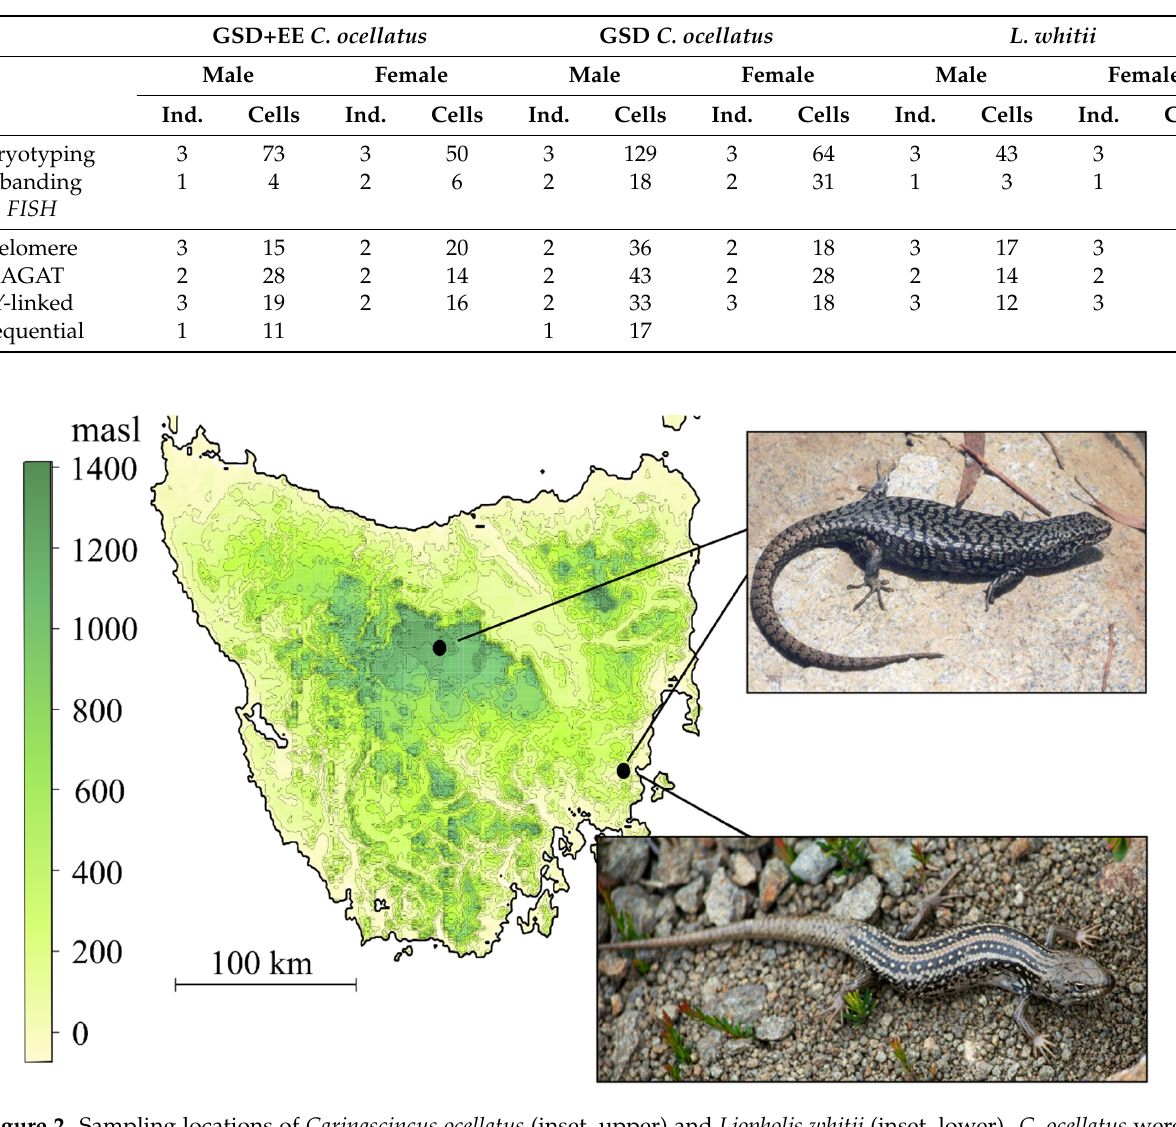
Table 1. Number of male and female individuals and cells examined from whole blood culture of GSD (high elevation) and GSD+EE (low elevation) populations of Carinascincus ocellatus and a single population of Liopholis whitii . ‘Sequential’ FISH represents Y-linked and microsatellite FISH in series.